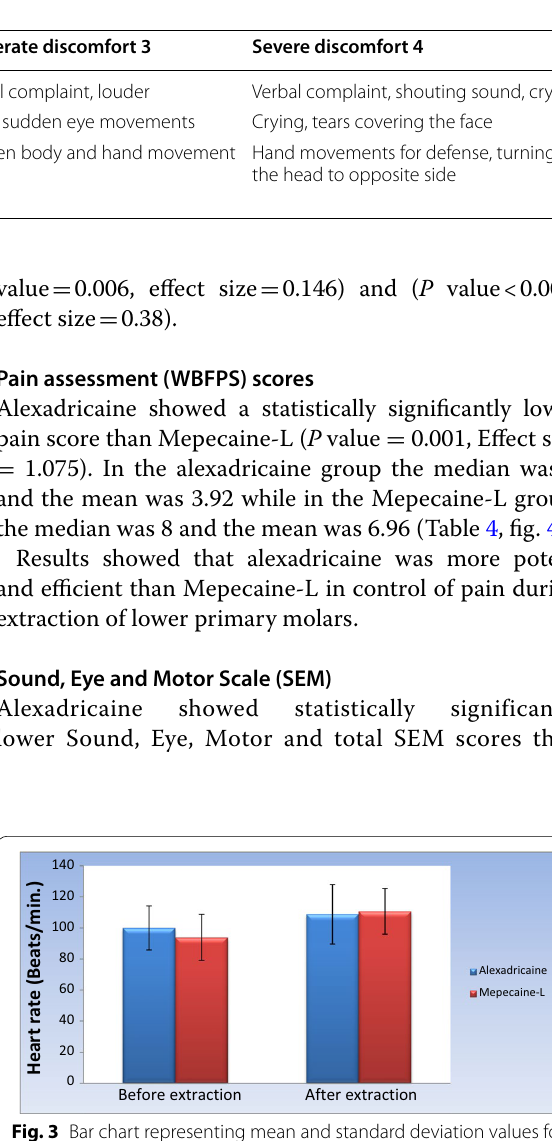
Table 1 Sound, eye, motor scale Parameter Comfort 1